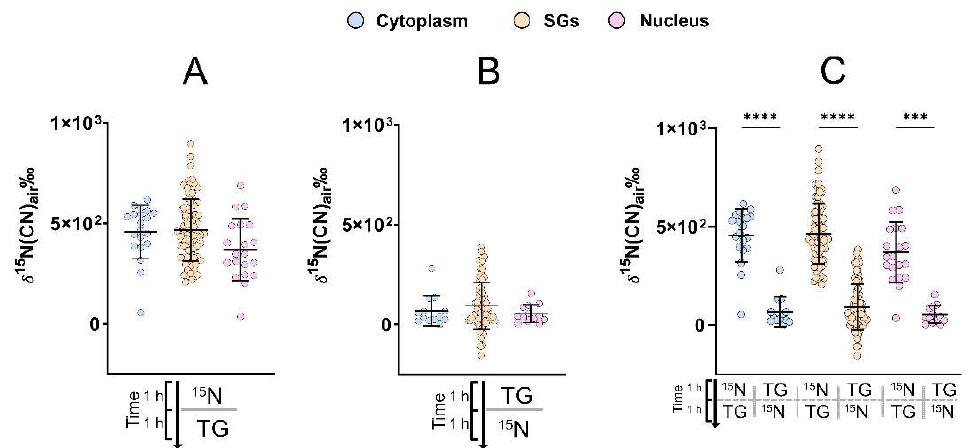
Figure 3. Protein turnover (expressed as 15 N enrichment) of SGs vs. cytoplasm and nucleus in NPCs. ( A ) 15 N enrichment in the cells that were incubated with 15 N leucine followed by ER stress ( 15 N → TG ) (n = 20). ( B ) 15 N enrichment in the cells that were ER-stressed followed by 15 N leucine incubation ( TG → 15 N ) (n = 13). ( C ) Comparison of the enrichment in the cytoplasm, SGs, and nucleus of these two groups of cells. The 15 N enrichment compared between different cellular compartments is not significantly different, while it is significantly different compared between the two cell groups (Dunn´s, *** p < 0.001, **** p < 0.0001); n is the number of cells.